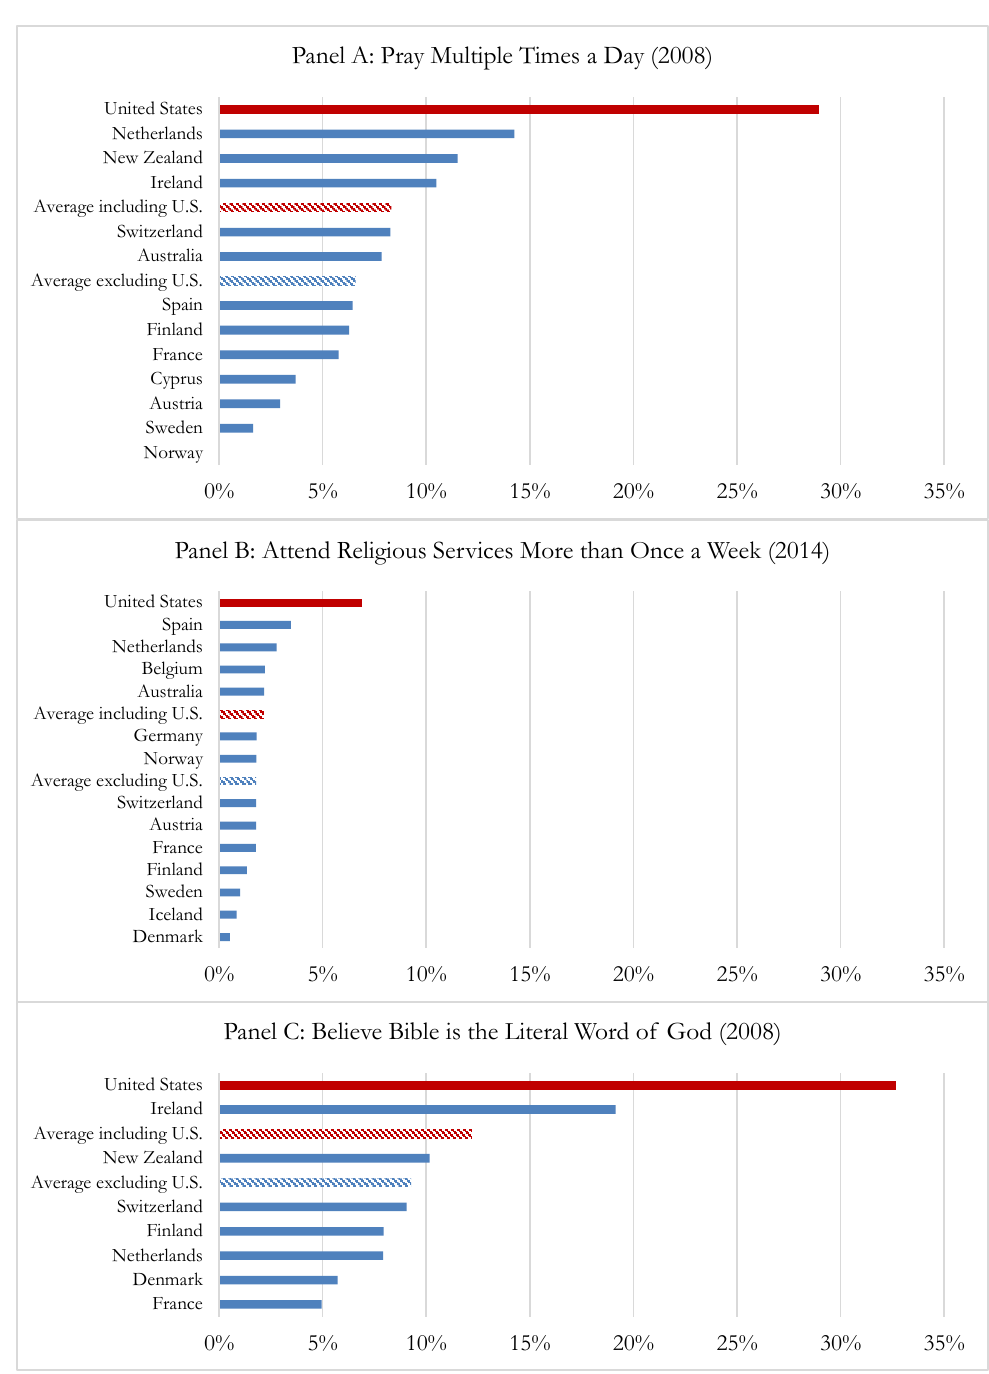
Figure 7: Cross-national intense religion, International Social Survey Programme. Source: International Social Survey Programme, 2008 and 2014. Note: Limited to historically Christian countries where the religion questions included the high intensity option and per capita GDP was at least $25,000 (World Bank 2010). View of the Bible was an optional question fielded in only some